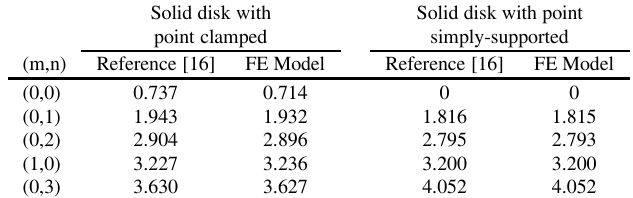
Table 2 Comparisons of frequency parameters Ω of out-of-plane vibration of a